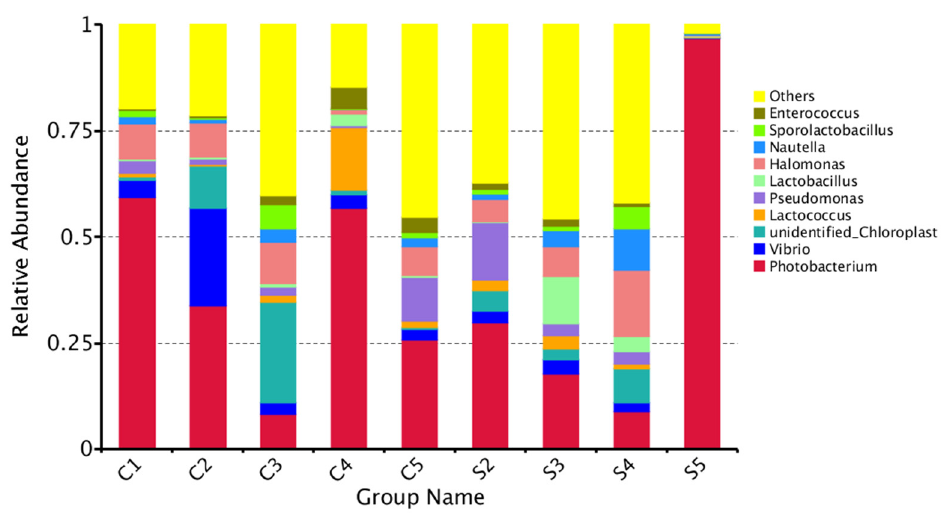
Figure 5. The relative abundance of the top 10 of the control and treatment groups at the same time points.